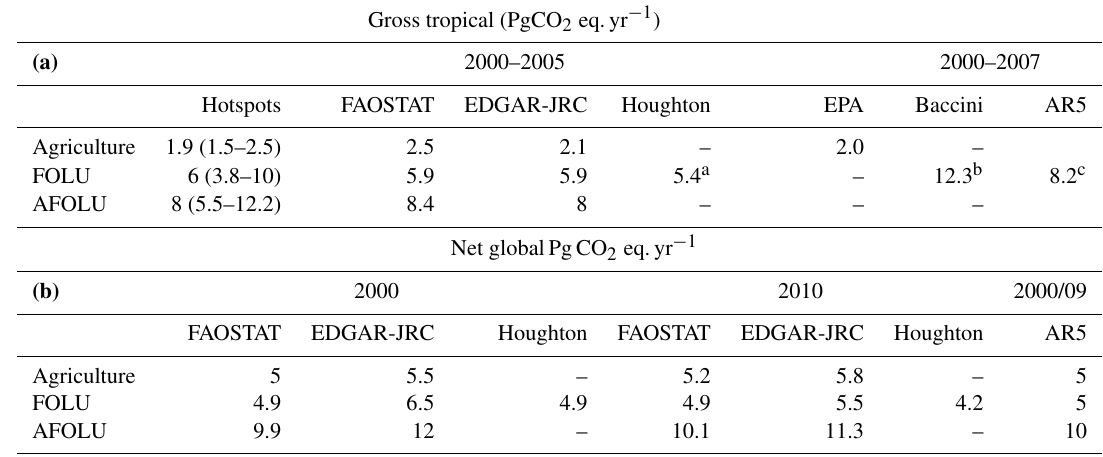
Table 2. Summary of (a) tropical gross emissions estimates for agriculture, FOLU (Forestry and Other Land Use), and AFOLU (Agriculture, Forestry, and Other Land Use) for all the datasets (Hotspots, FAOSTAT, EDGAR, EPA, Houghton; 2000–2005) and published data (Baccini et al., 2012; AR5 Smith et al., 2014; 2000–2007), and of (b) net global estimates as reported by Tubiello et al. (2015). Houghton and EPA respectively offer FOLU and agricultural data only; therefore estimates for AFOLU are not complete.